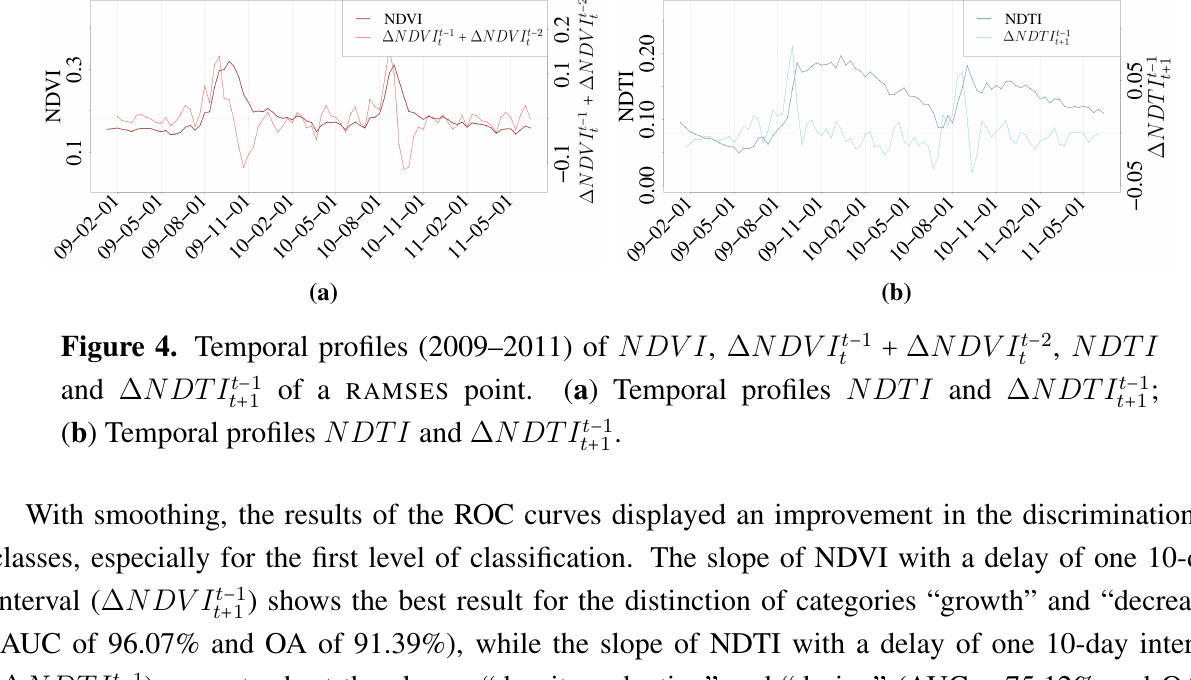
, NDT I + ∆ NDV I t − 2 t t